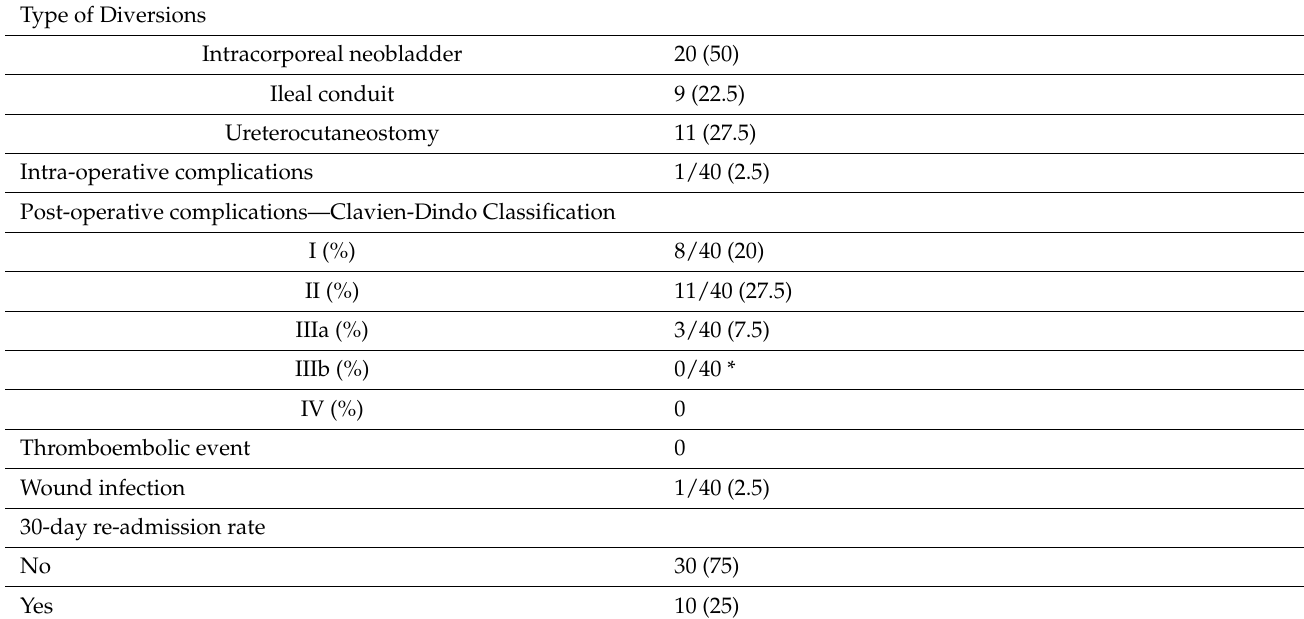
Table 2. Intra-operative and post-operative data and complication